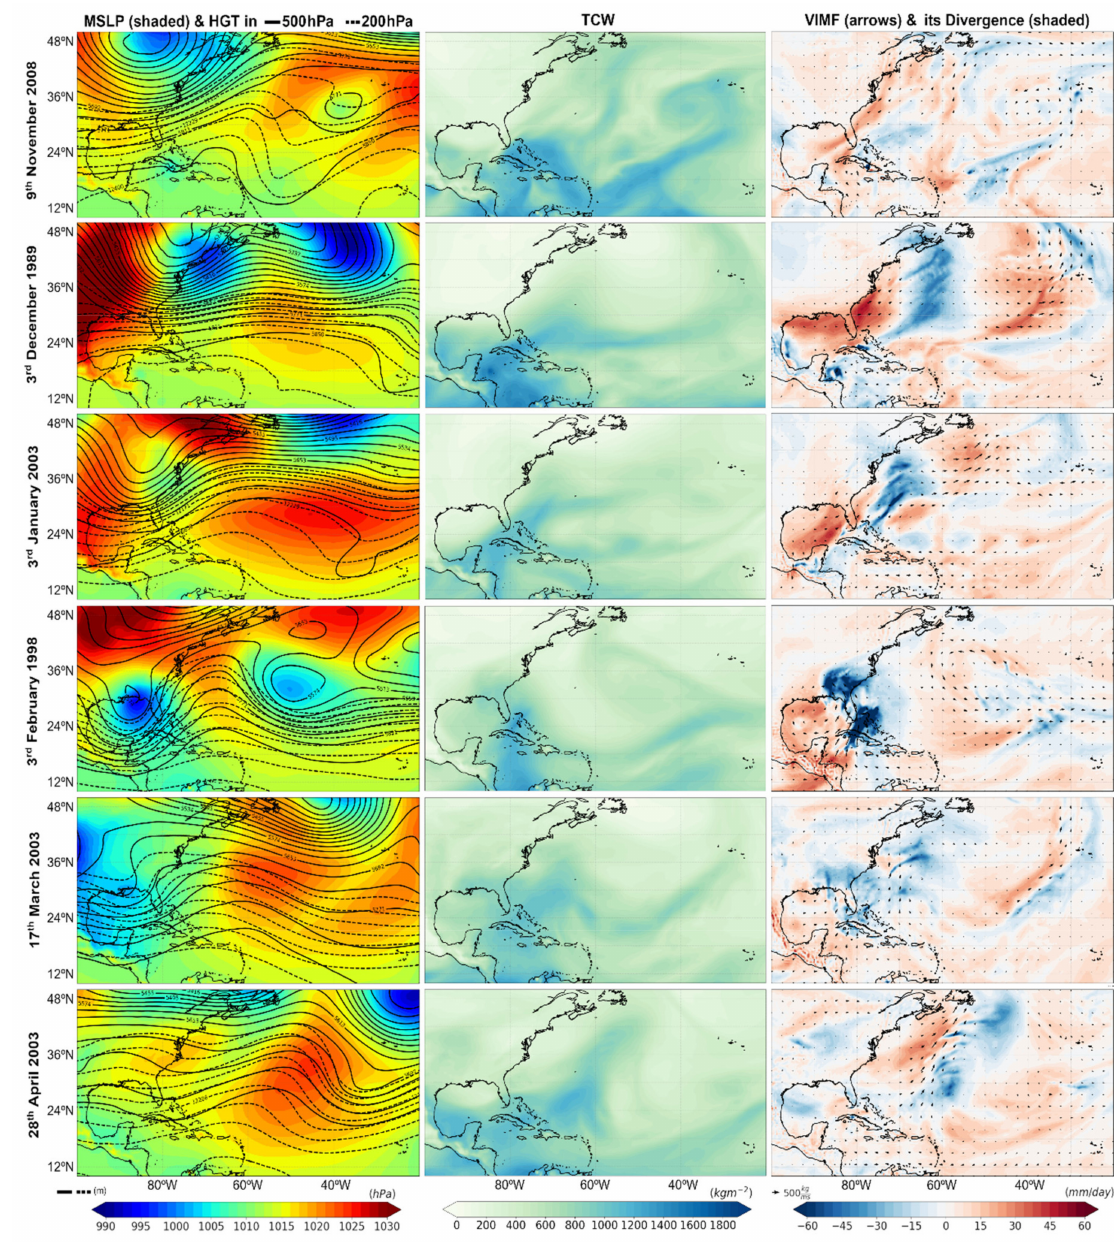
Figure 10. The left column shows MSLP (shaded) and HGT at 500 hPa (solid line) and 200 hPa (dashed line); the central column the TCW, and the right column VIMF (arrows) and its Divergence (shaded) for every day of the top monthly ranking extreme precipitation extremes from November to April (Dry period). Period